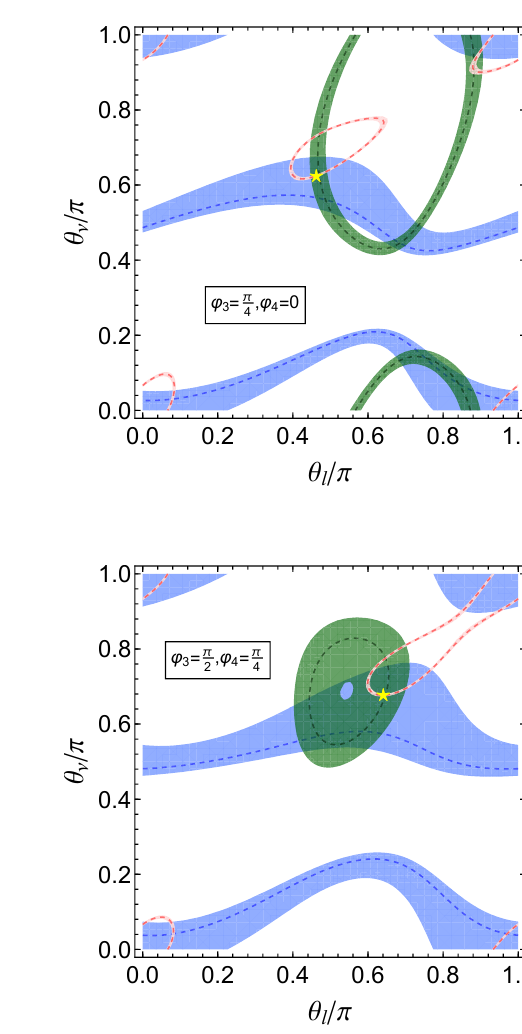
Figure 5 . Contour plots of sin 2 (cid:18) ij in the (cid:18) (cid:23) (cid:0) (cid:18) l plane for U II ; 2 with n = 4. The red, green and blue areas denote the 3 (cid:27) contour regions of sin 2 (cid:18) 13 , sin 2 (cid:18) 12 and sin 2 (cid:18) 23 respectively. The dashed contour lines represent the corresponding experimental best (cid:12)t values. The 3 (cid:27) ranges as well as the best (cid:12)t values of the mixing angles are adapted from [8]. The best (cid:12)tting values of (cid:18) l;(cid:23) are indicated with yellow